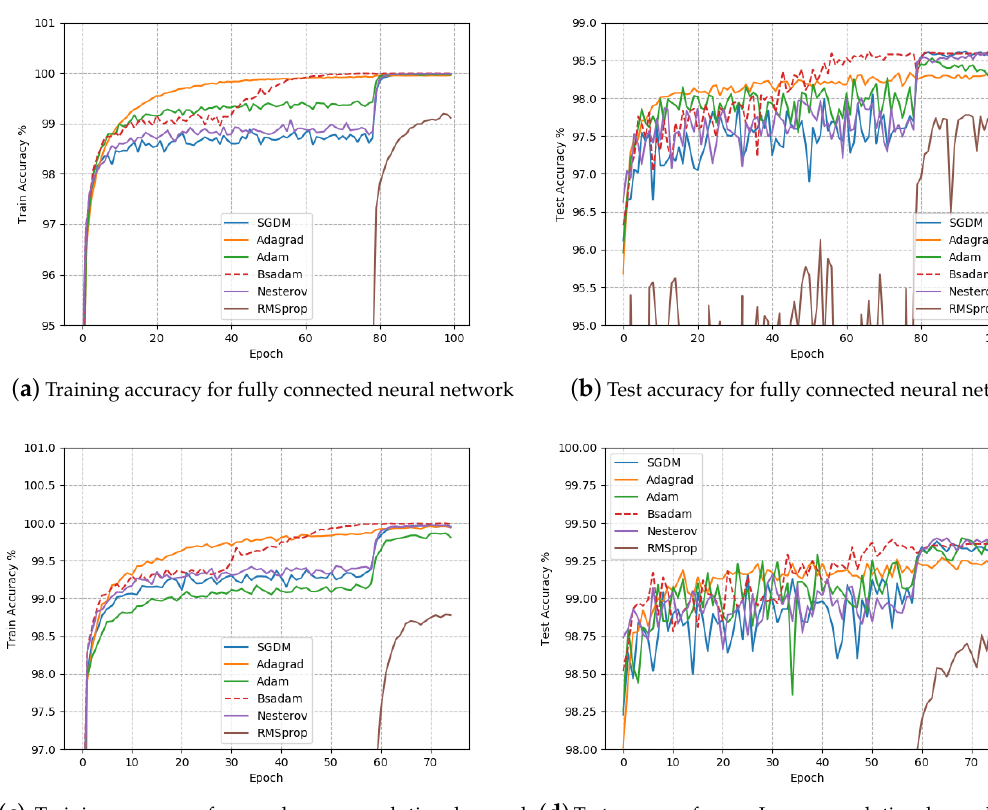
Figure 3. Training and test accuracy for fully connected neural network and one-layer convolutional neural network on